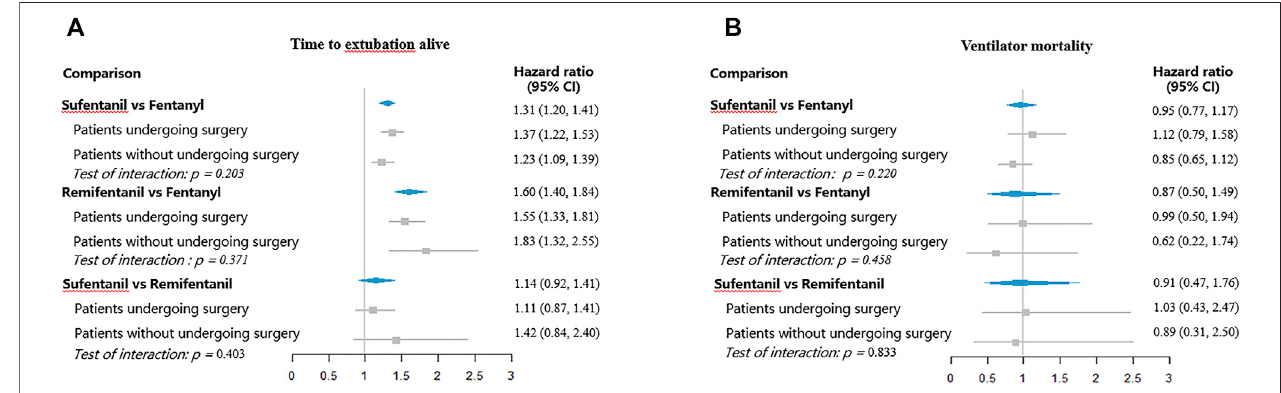
FIGURE 3 | Hazard ratios for extubation and ventilator mortality with different opioids. (A) Time to extubation alive; (B) Ventilator mortality.